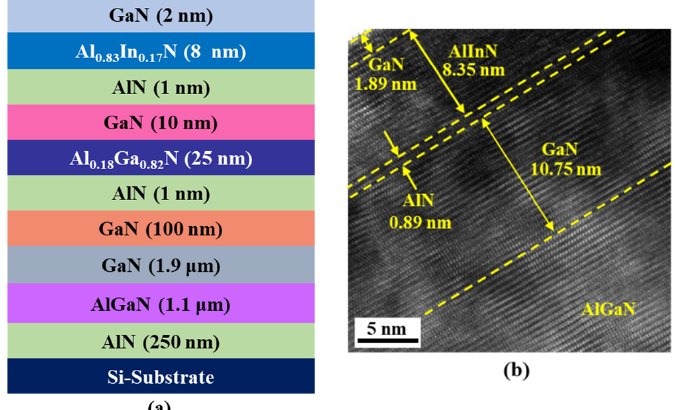
Figure 1. ( a ) Schematic structure and ( b ) high-resolution transmission electron microscopy image of epitaxial layers.